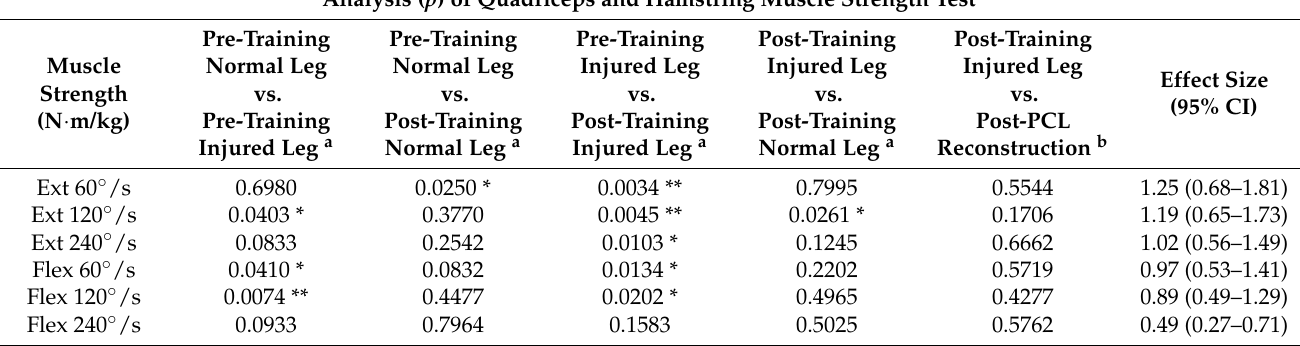
Table 3. The analysis of knee quadriceps and hamstring muscle strength between the study (training) and post-PCL reconstruction groups.